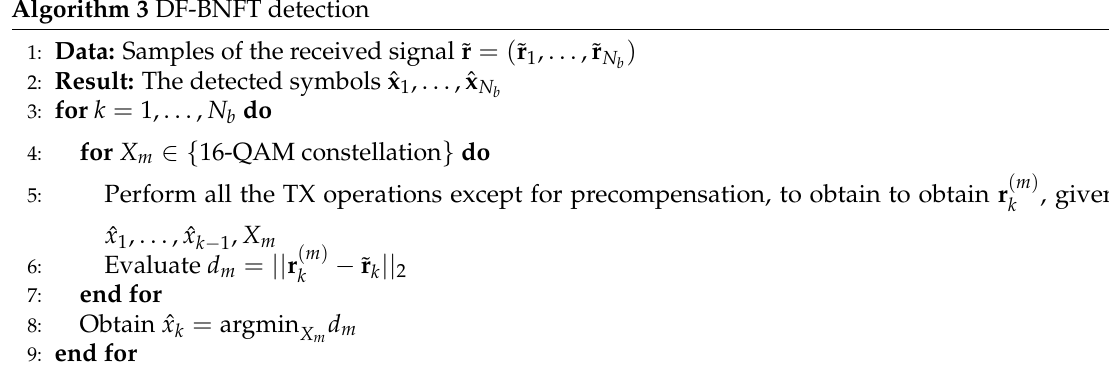
Algorithm 3 DF-BNFT